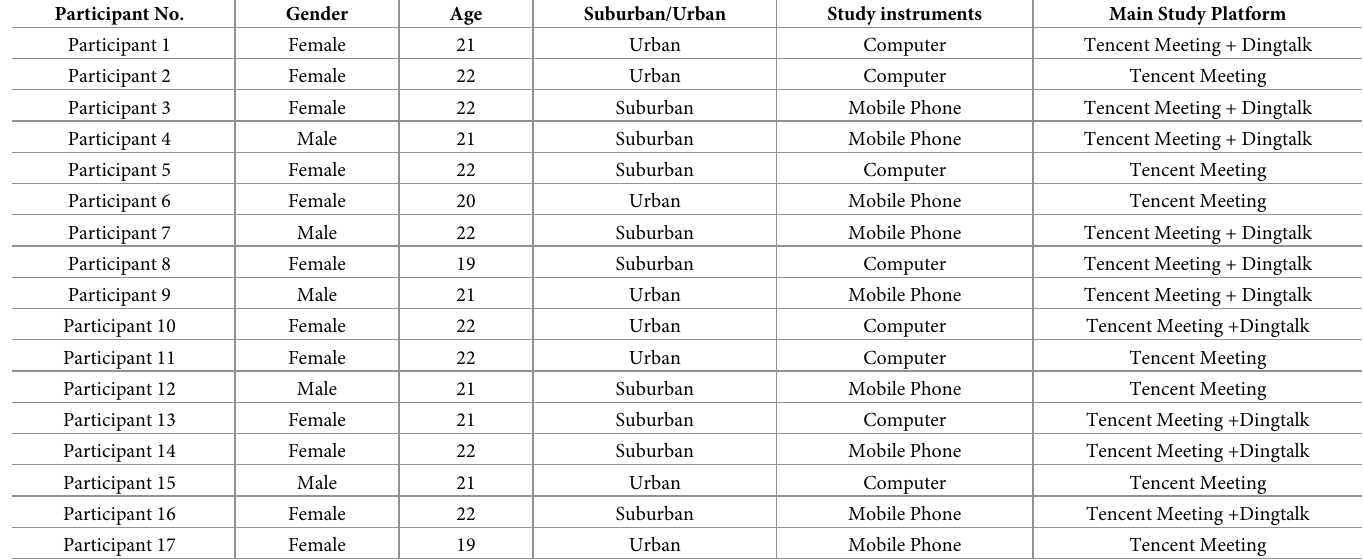
Table 2. Participant characteristics (n = 17).